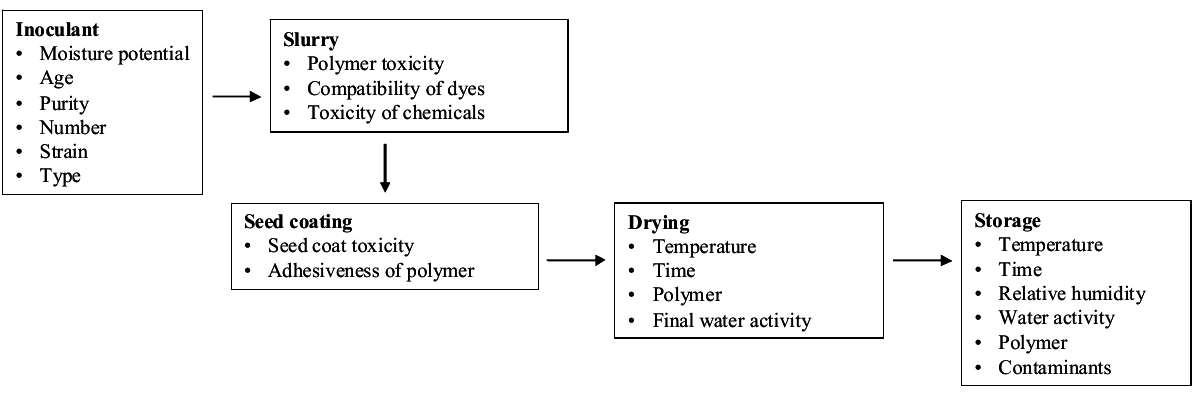
Figure 1. Factors affecting survival of rhizobia during commercial inoculation of legume pasture